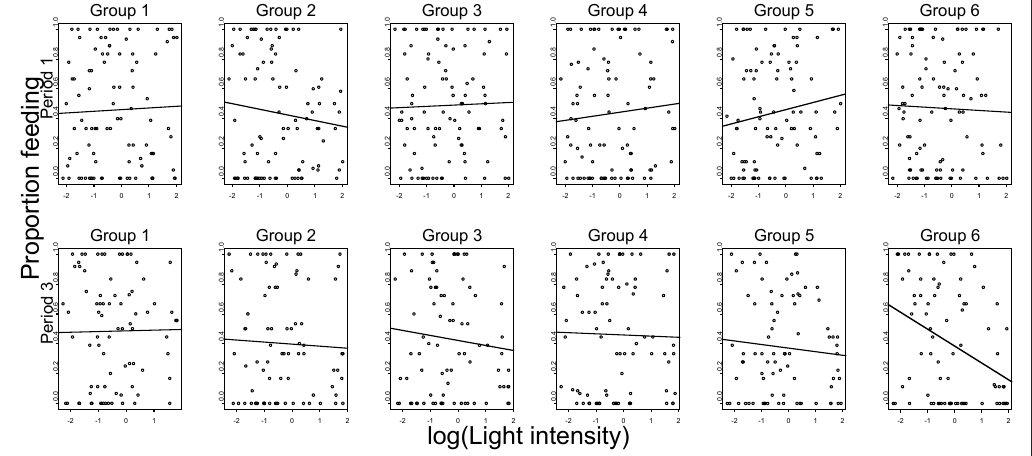
Fig. 4. Linear regression lines indicating that feeding did not depend on light intensity during the arctic summer, Finnmark, June